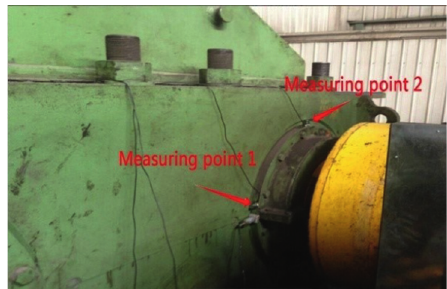
Figure 8: Sensor placement location.